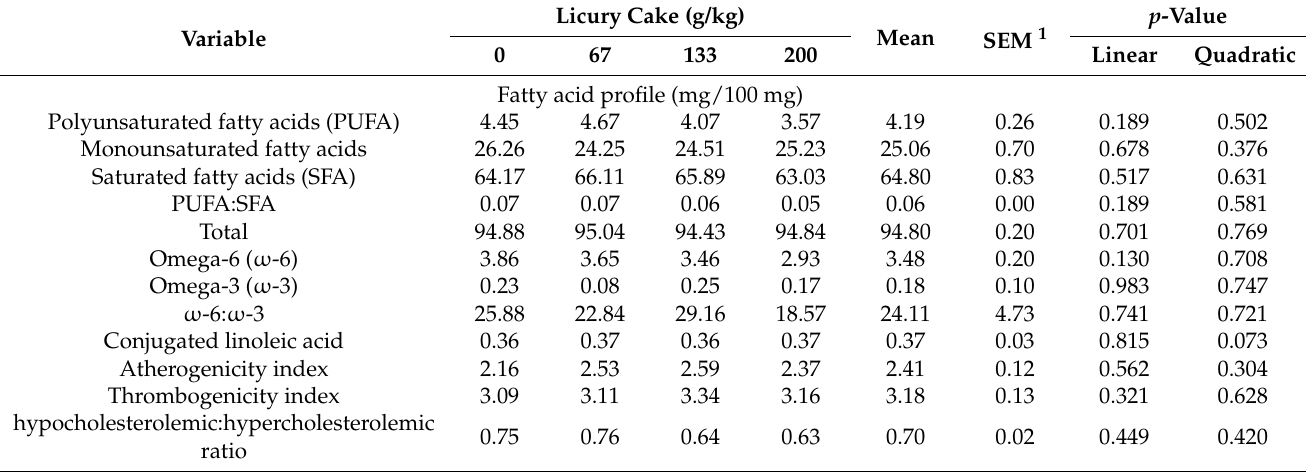
Table 4. Fatty acid profile of milk from lactating goats fed diets with increasing levels of licury